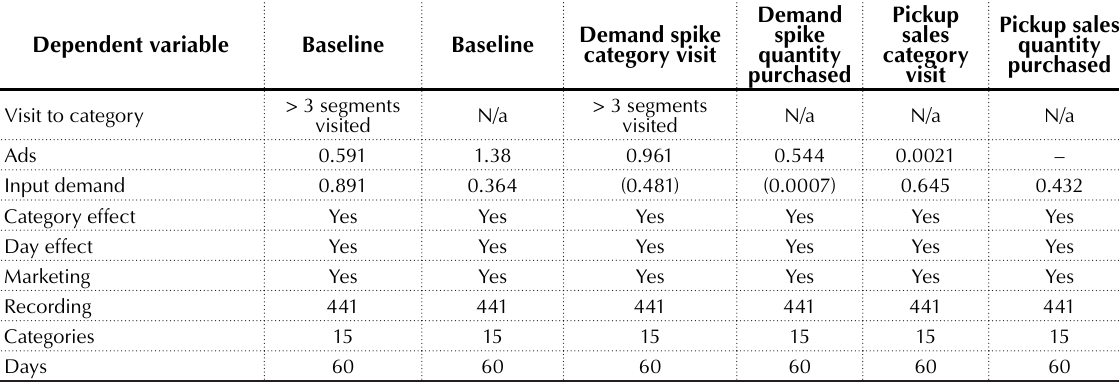
Table 4. Tests: the recording unit is day and category